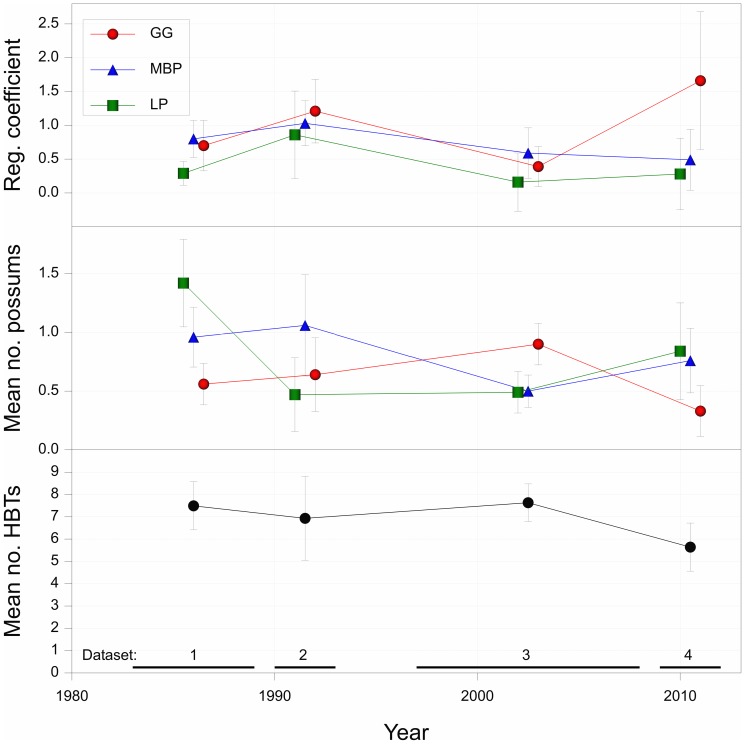
Estimated regression coefficients.Estimated regression coefficients (with standard errors) in the fitted relationship between abundance of three species of marsupial and abundance of hollow-bearing trees, plotted over time, together with the associated mean numbers per site of hollow-bearing trees, and of each species of arboreal marsupial.